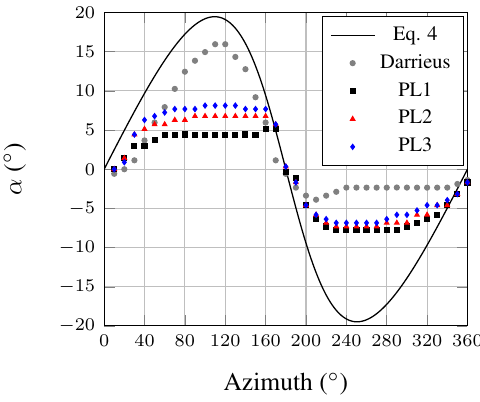
Figure 16. Measured angle of attack for the Darrieus and the pitching law cases, λ = 3.